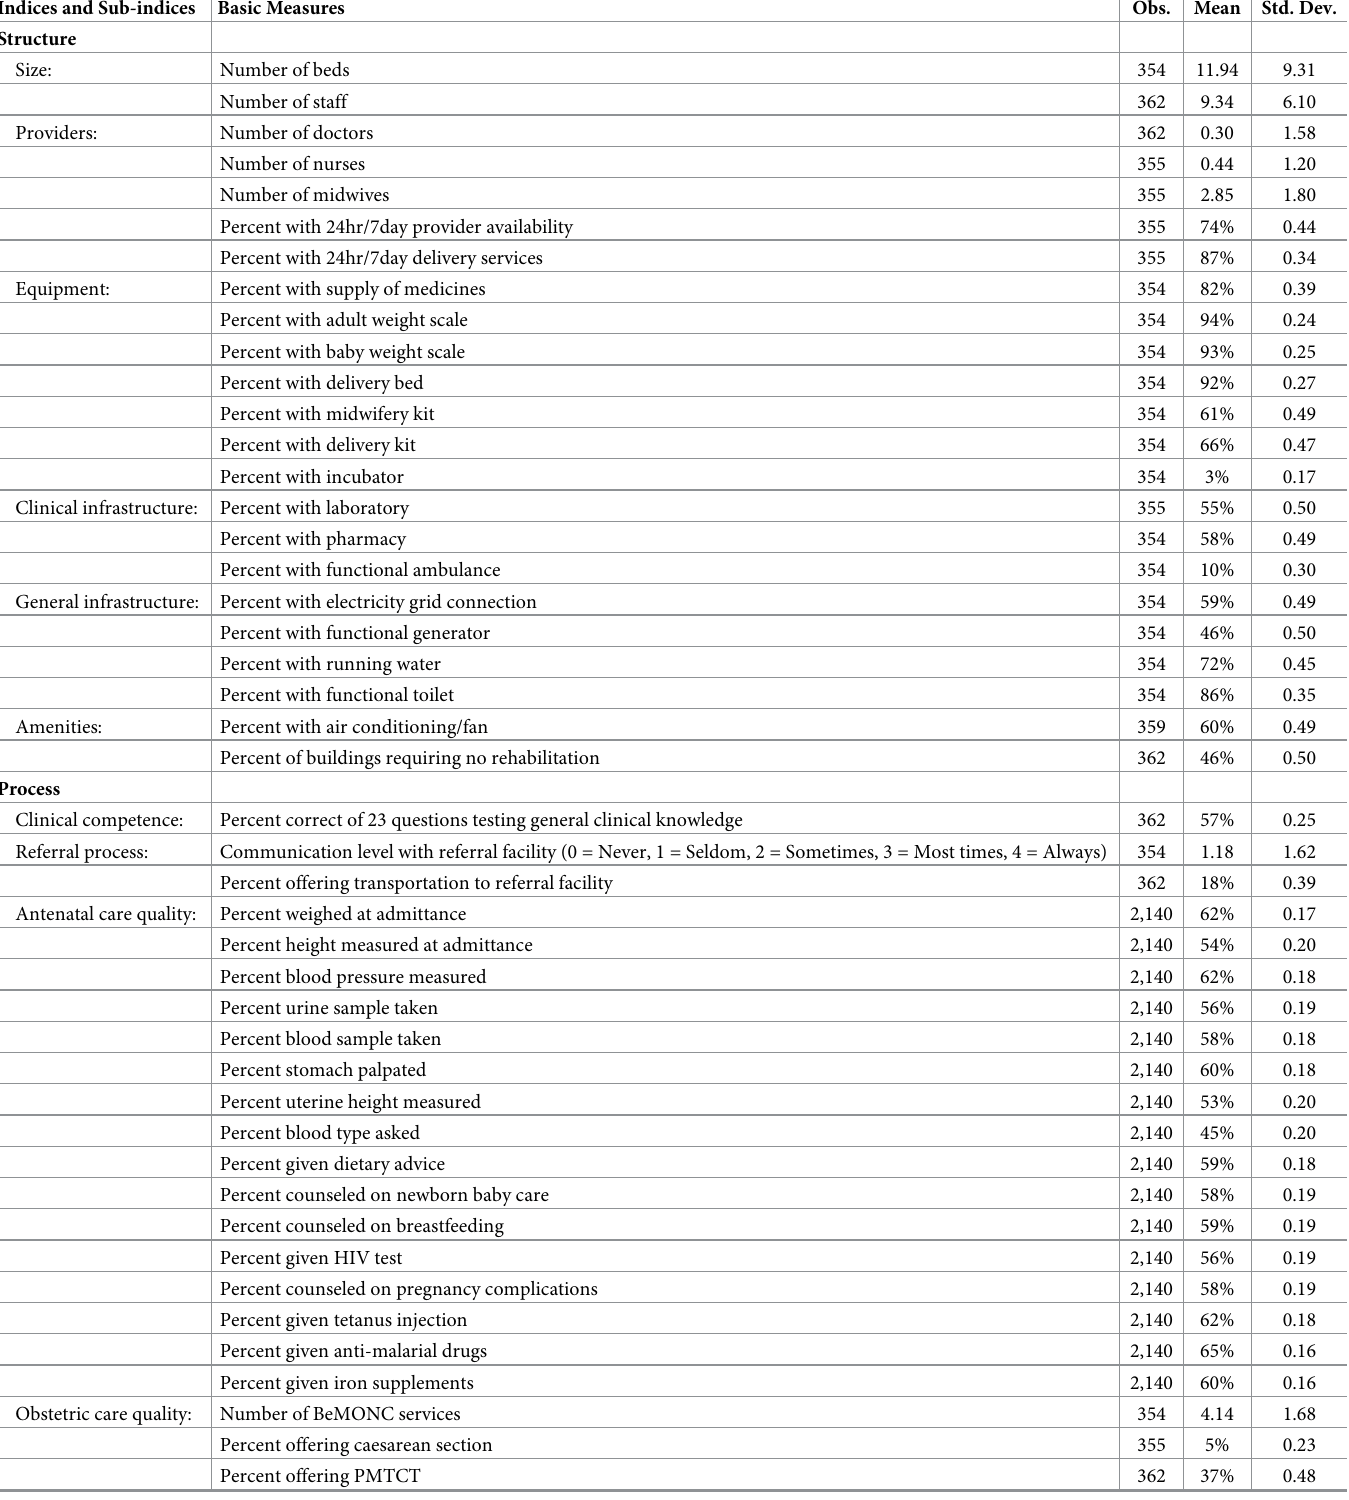
Table 2. Summary statistics of index components. Indices and Sub-indices Basic Measures Obs. Mean Std.